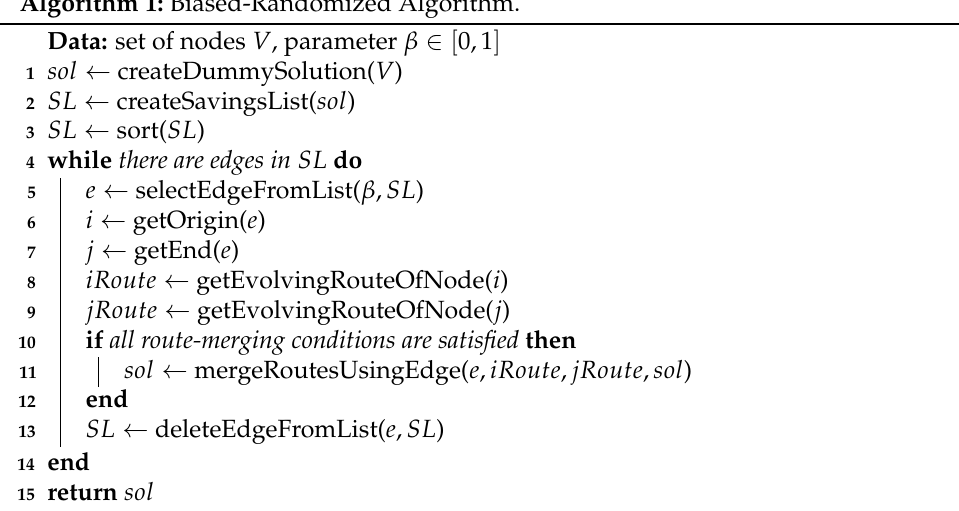
Algorithm 1: Biased-Randomized